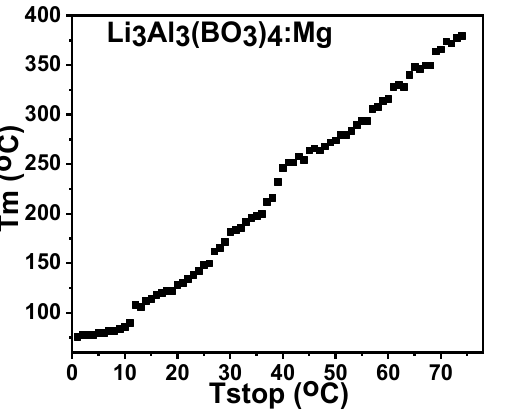
Figure 9. The Tm versus Tstop plot for the 0.1%Mg-doped lithium aluminium borate.